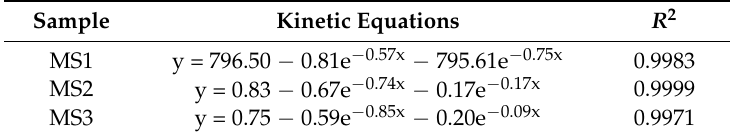
Table 1. Fitting equations of the release profiles of the azoxystrobin microspheres.